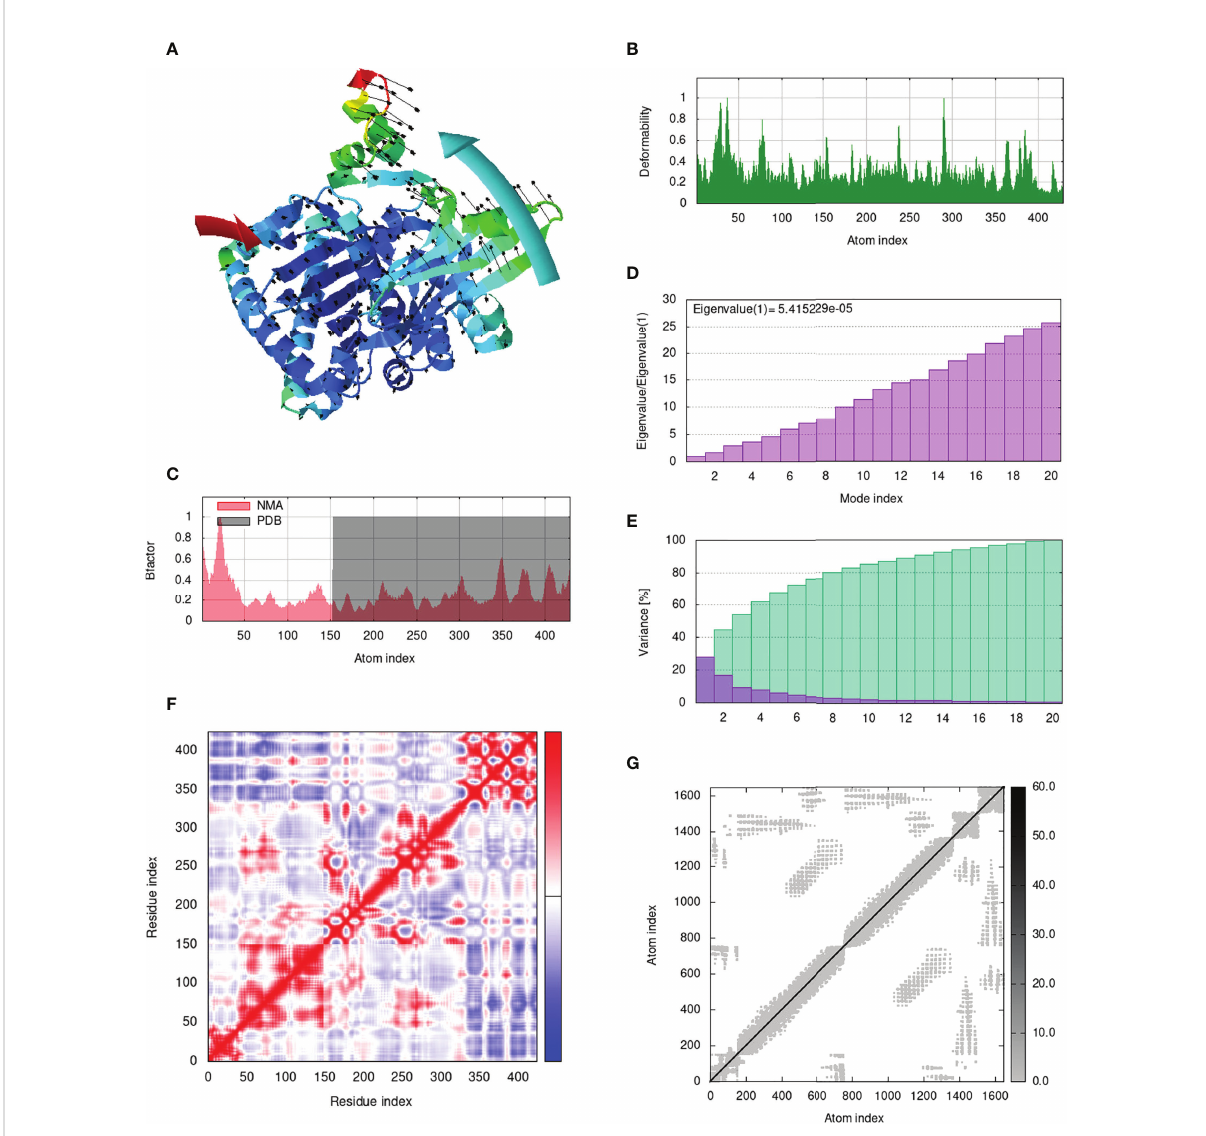
FIGURE 9 Analysis of the vaccine-MHC I complex in normal mode. (A) Structural strength of the re fi ned protein-protein complex mobility; (B) deformability in relation to atoms; (C) B-factor in relation to atoms; (D) eigenvalue in relation to modes; (E) Structural variance; (F) covariance in relation to residue; (G) elastic network in relation to